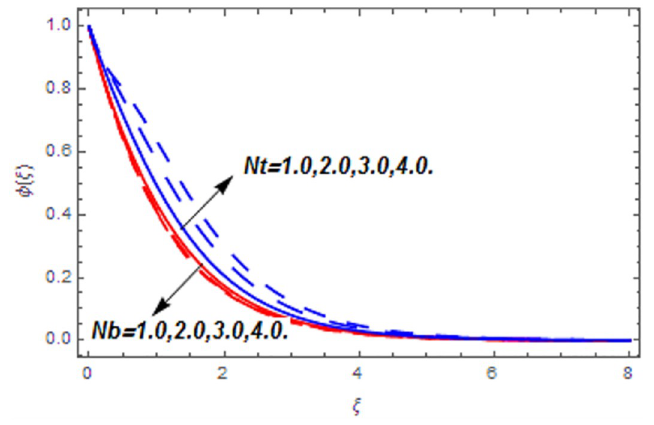
Fig 9. Concentration profiles versus Brownian motion and thermophoresis